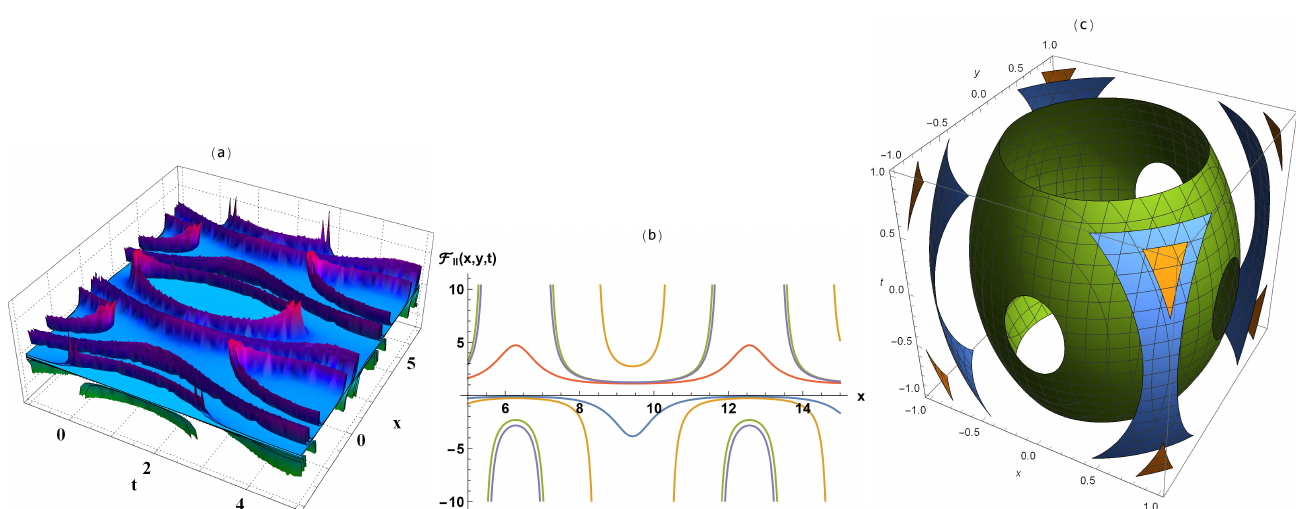
Figure 4. Computational wave solutions of Equation (29) in 3D ( a ), 2D ( b ), and contour ( c ) plots.